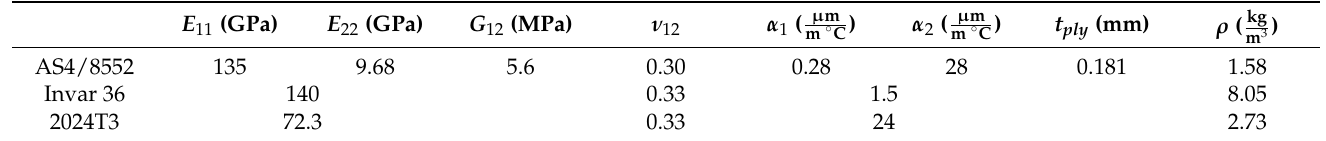
Table 1. Material